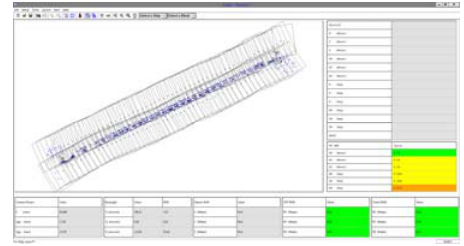
Figure 13: CalQC bundle adjustment project – Fryer Dam